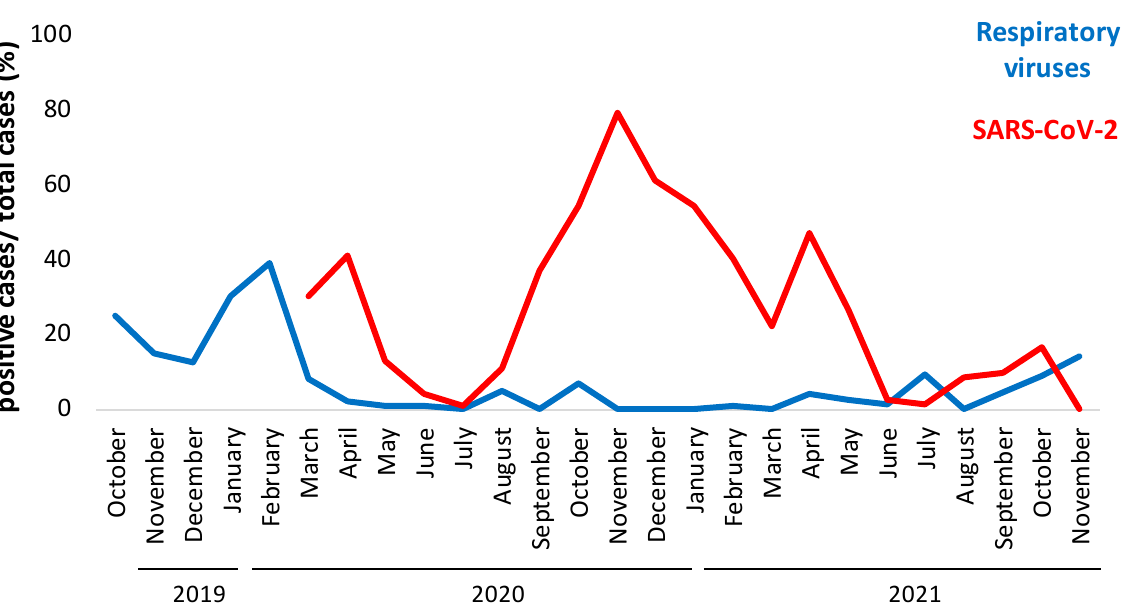
Figure 2. Epidemiological curve of positive cases registered every month from October 2019 to November 2021 of SARS-CoV-2 (red line) and other respiratory viruses (blue line). Samples were analyzed using BioFilmArray RP2.1 plus . Percentages of positive cases (ordinate axis) were calculated as total number of cases analyzed every month.